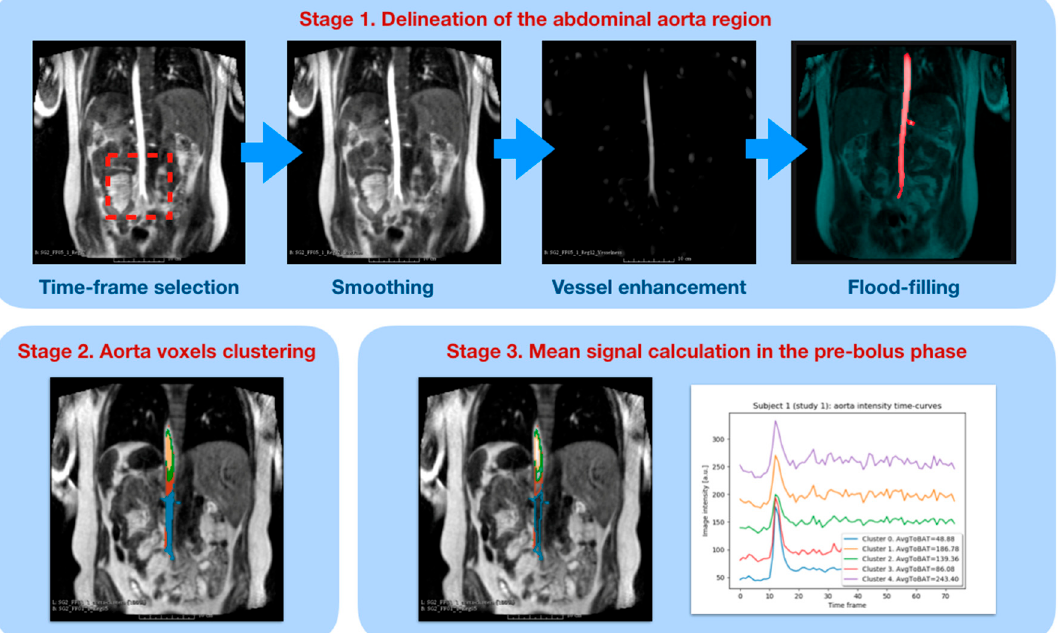
Figure 2. Steps of automatic arterial input function (AIF) determination algorithm.